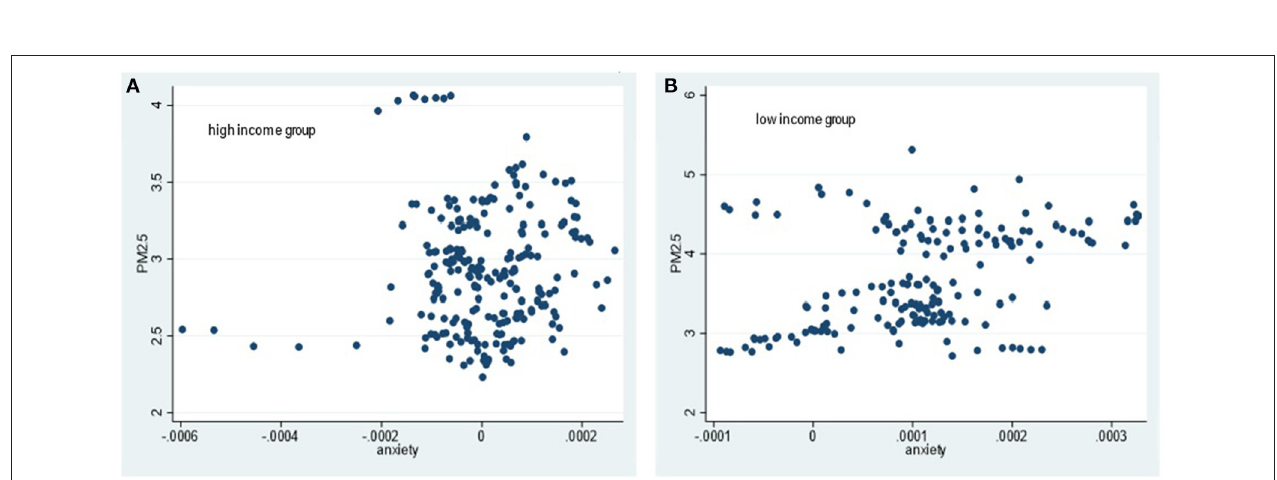
FIGURE 2 | Scatter diagram of relationship between PM2.5 concentration and depression in different income groups. (A) High income group. (B) Low income group.